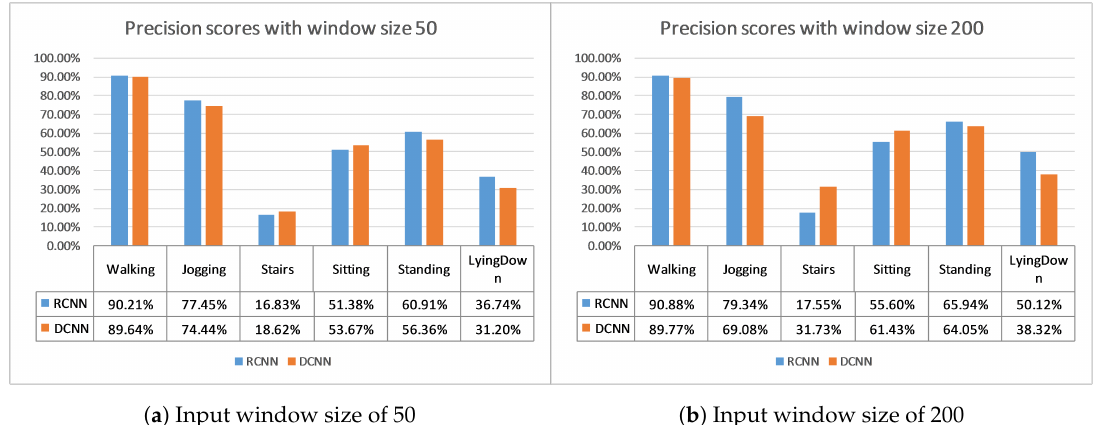
Figure 5. Average precision scores of the 10-fold cross-validation of the Actitracker